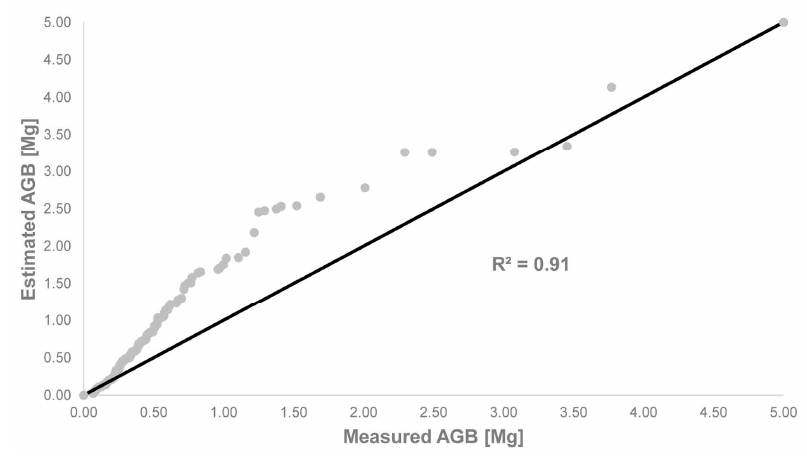
Figure 8. Calculated AGB by means of the individual tree measurements compared to estimated